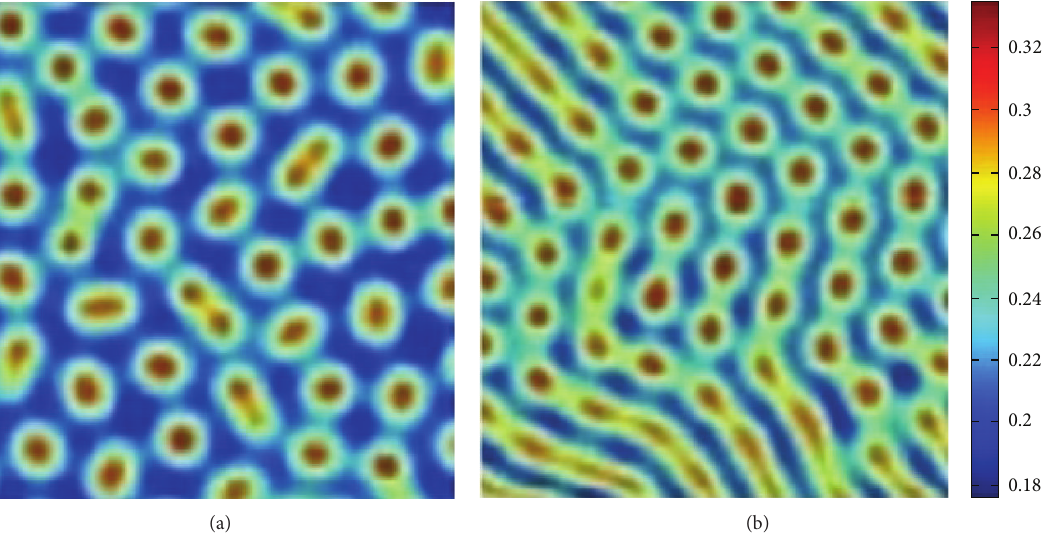
Figure 1: Snapshots of contour pictures of the vegetation at 𝑡 = 1000 with 𝛾 = 1.6 , 𝜎 = 1.6 , 𝜇 = 0.5 , 𝜌 = 1.5 , 𝐷 = 10 , 𝛼 = 3 , and 𝛽 = 3 . (a) 𝑝 = 0.45 and ] = 0 ; (b) 𝑝 = 0.13 and ] = 50 .